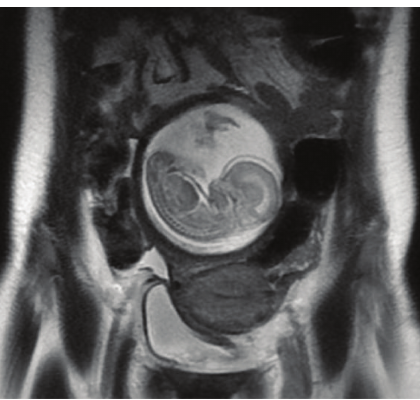
Figure 3: A hysterosalpingogram demonstrating contrast extrava- sation through the left uterine horn and fallopian